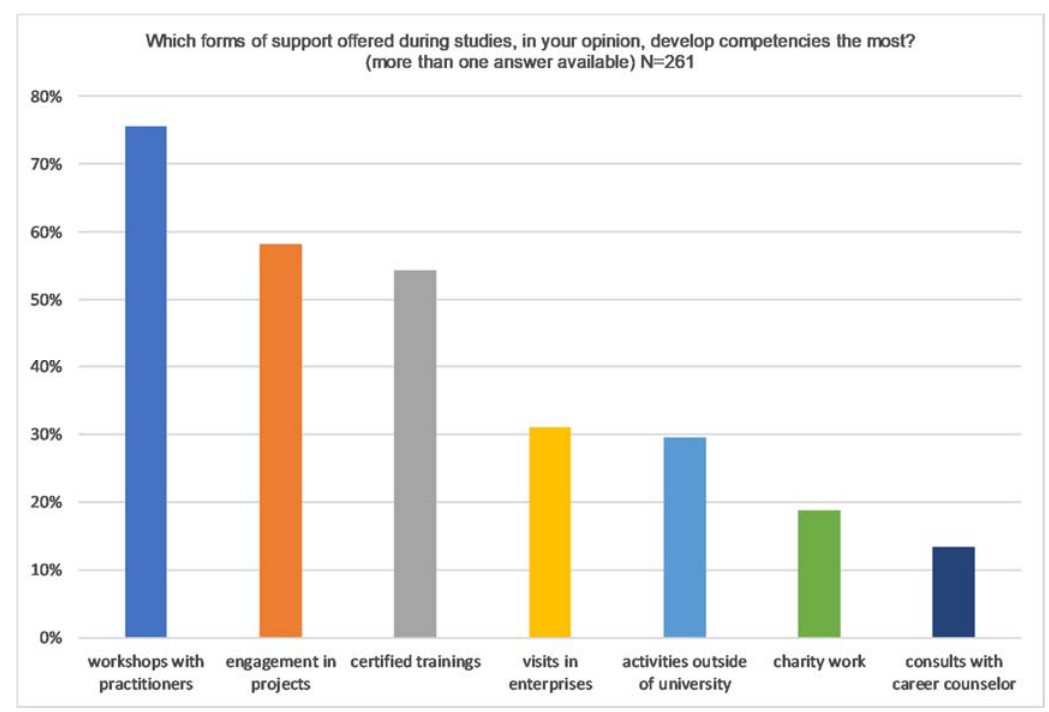
Figure 4. Extracurricular activities supporting the development of competency.